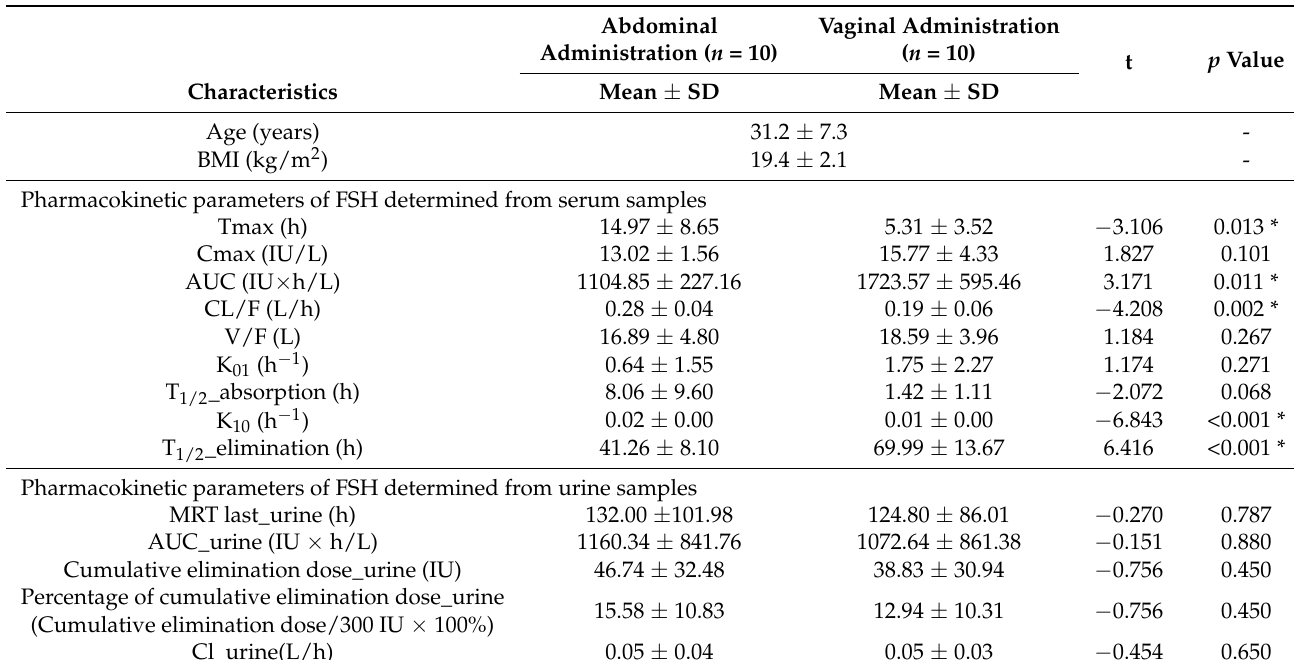
Table 2. Demographic characteristics and pharmacokinetic parameters of FSH in subjects receiving 300 IU rhFSH through abdominal/vaginal